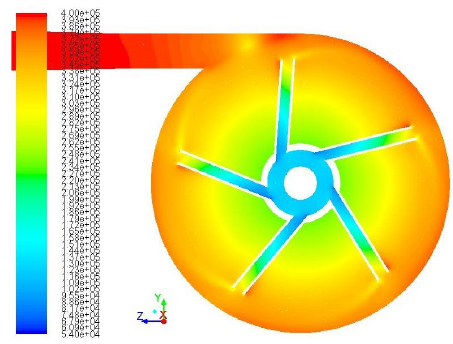
Figure 15: Static pressure distribution [Pa] in Impeller 2